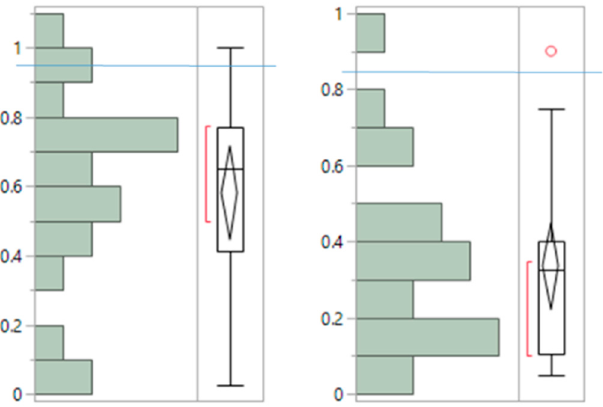
Figure B2. Estimation of a robust max on each component vector (blue line on top of each histogram).